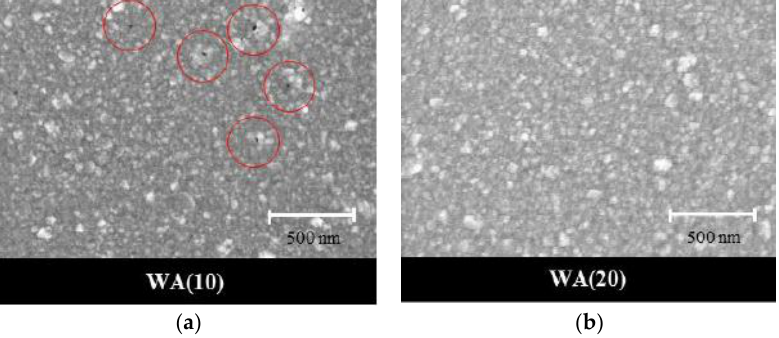
Figure 7. Scanning electron microscope (SEM) images of WA films at ( a ) 10-nm Ag (A10) film and ( b ) 20-nm Ag (A20) film.